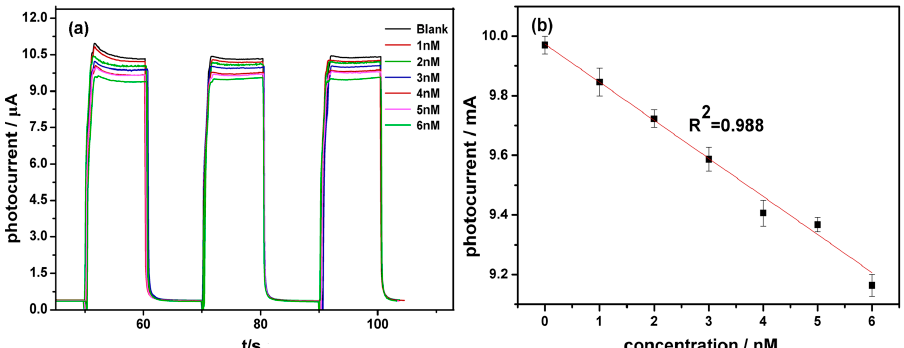
Figure 5. The photocurrent responses of AFB 1 : ( a ) the photocurrent responses of AuNPs/AChE/TiO 2 NTs in 0.1 M PBS solution (pH 7.4) containing 0.1 mM ATCl after adding different concentration of AFB1; ( b ) standard curve line of different concentration of AFB 1 , N = 3).